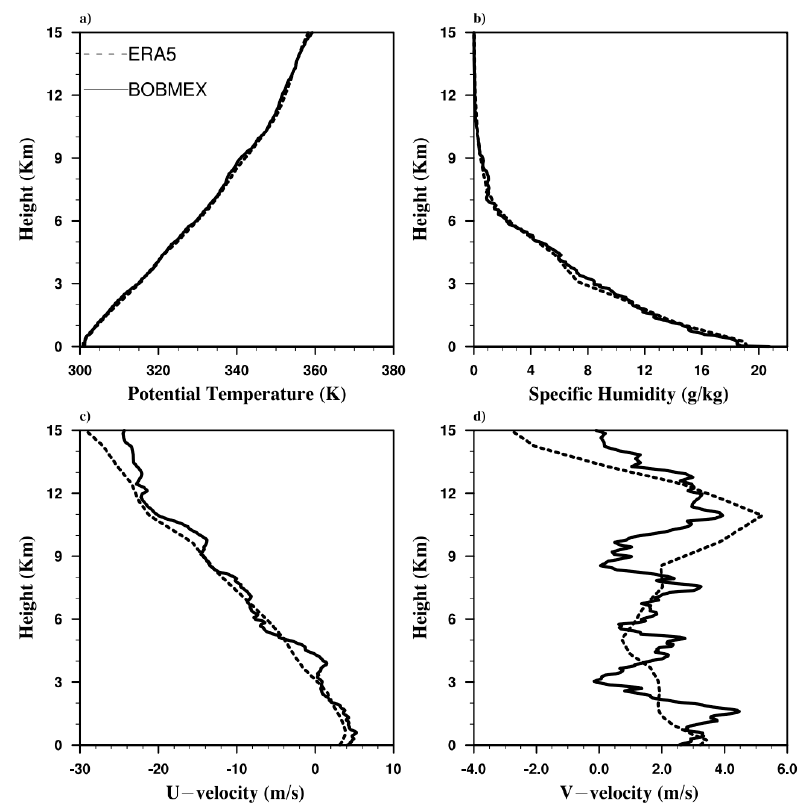
Figure 1. Initial profile of: ( a ) potential temperature; ( b ) specific humidity; ( c ) u − velocity; and ( d ) v − velocity from ERA5 compared with observations (BOBMEX).